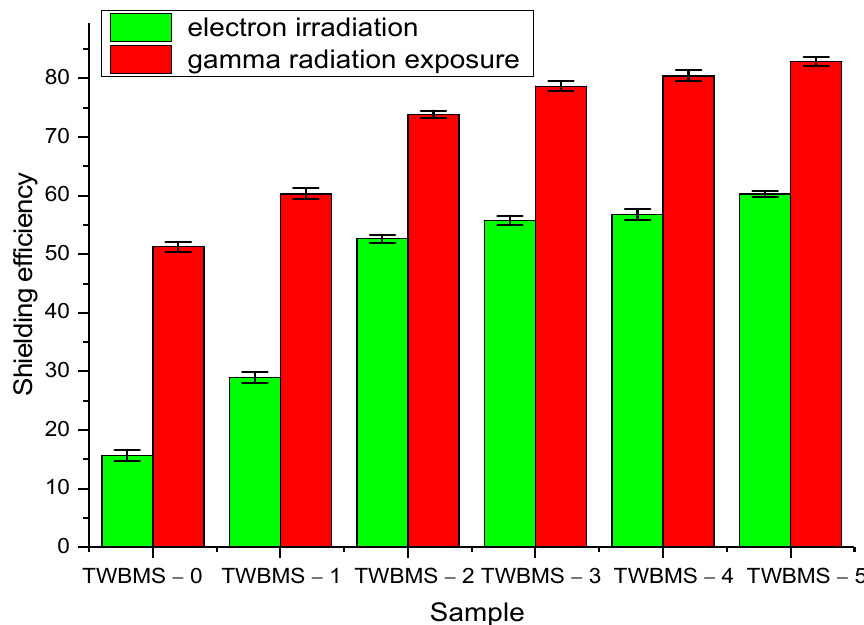
Figure 8. The results of a comparative analysis of the shielding efficiency when measuring the CVC at the maximum radiation dose (500 kGy).